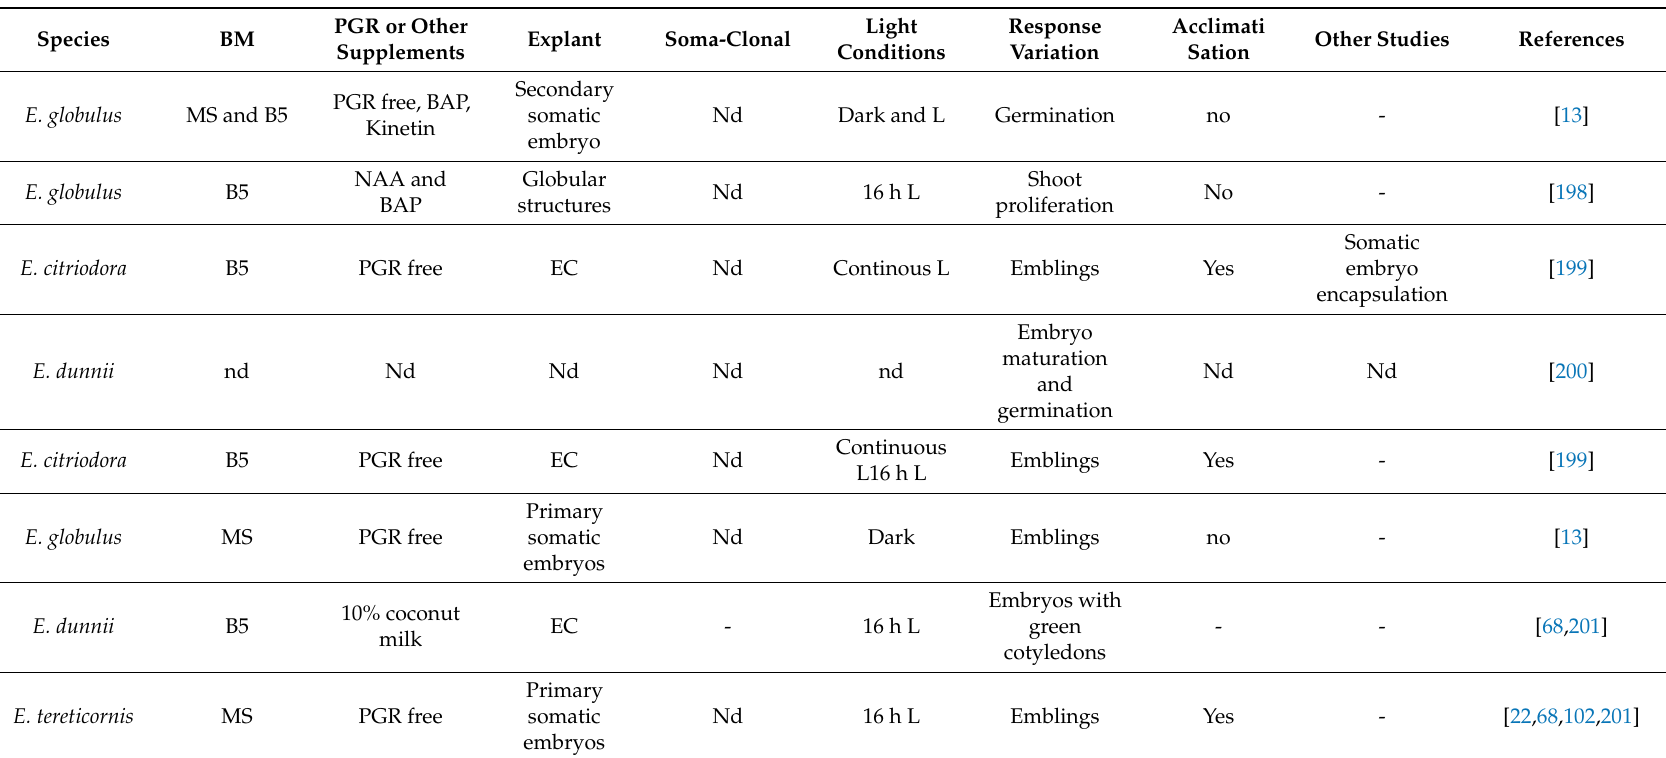
Table 1. Some examples of Eucalyptus regeneration in di ff erent culture conditions